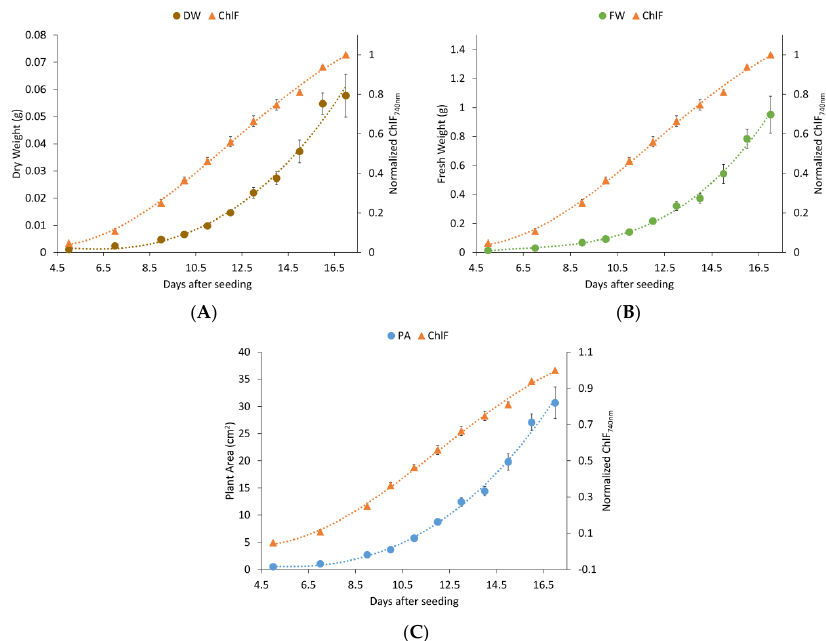
Figure A1. Dry weight (DW) ( A ), fresh weight (F6W) ( B ), plant area (PA) ( C ) and relative chlorophyll fluorescence values (ChlF) as a function of days after seeding. Values are means of observed values from four experimental replicates ( n = 12). Error bars show standard error of the means (SEM).